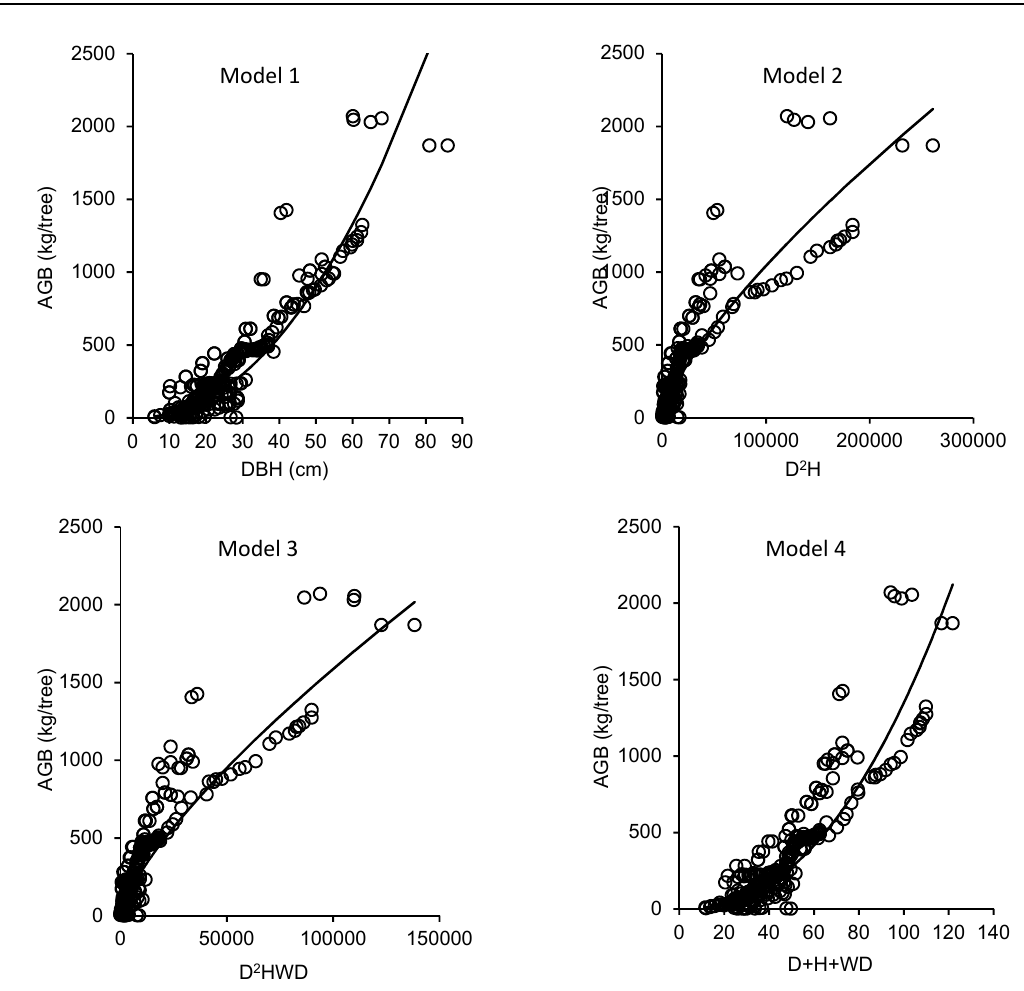
Figure A1. The observed AGB (open circles) and fitted values (smooth lines) using models 1–4 in the arithmetic domain.